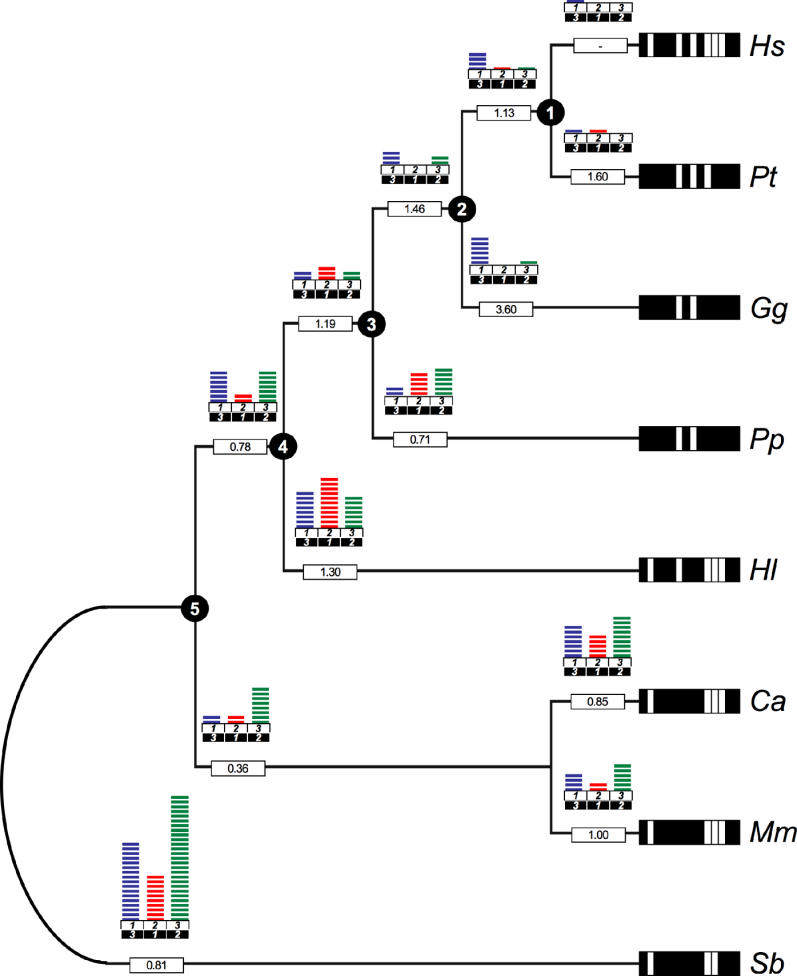
Evolutionary Oscillation between XLαs and ALEX Frames Revealed from Nucleotide Substitution AnalysisThe ratio of maximum likelihood estimates of nonsynonymous rates between the two frames (XL
K
A/ALEX
K
A) is shown on each branch. A series of colored bars above each branch shows the number of nucleotide substitutions at each codon position reconstructed using parsimony. Each bar represents a single substitution. The codon positions are numbered as follows: black letters on white background (XLαs frame); white letters on black background (ALEX frame). Boxes at the ends of external branches show repeat structure of the XL-exon in each species (white = deletion). Species abbreviations are as in Figure 1.